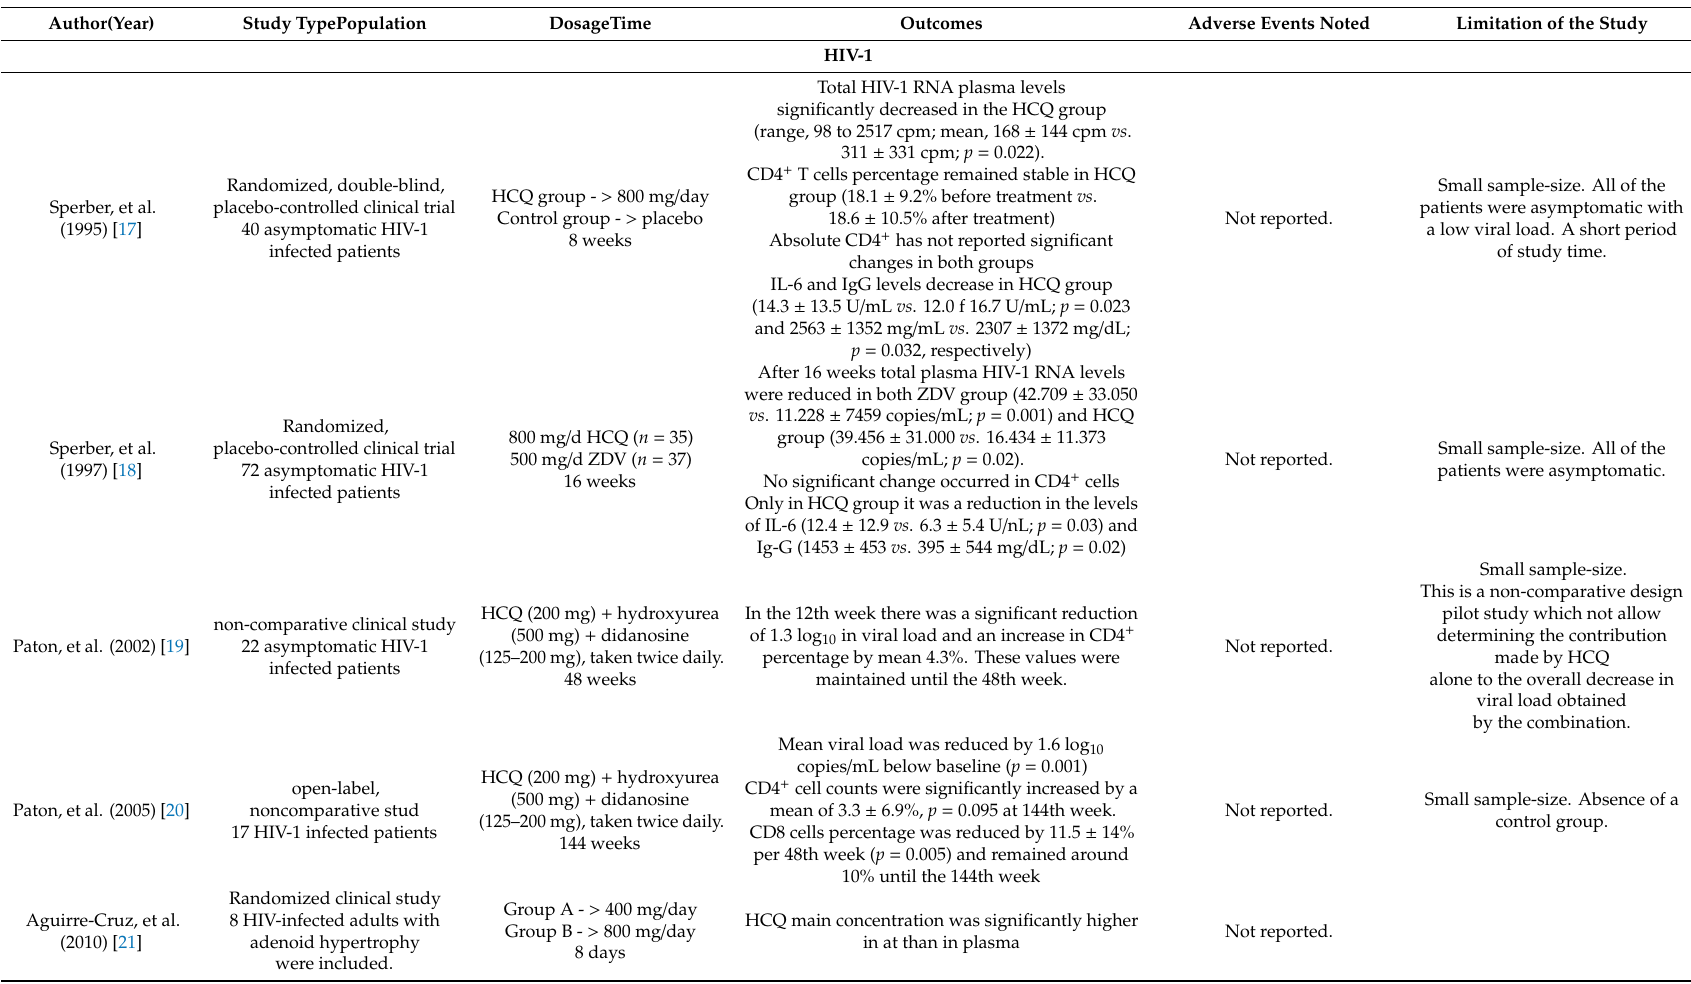
Table 1. Antiviral e ff ects of HCQ,